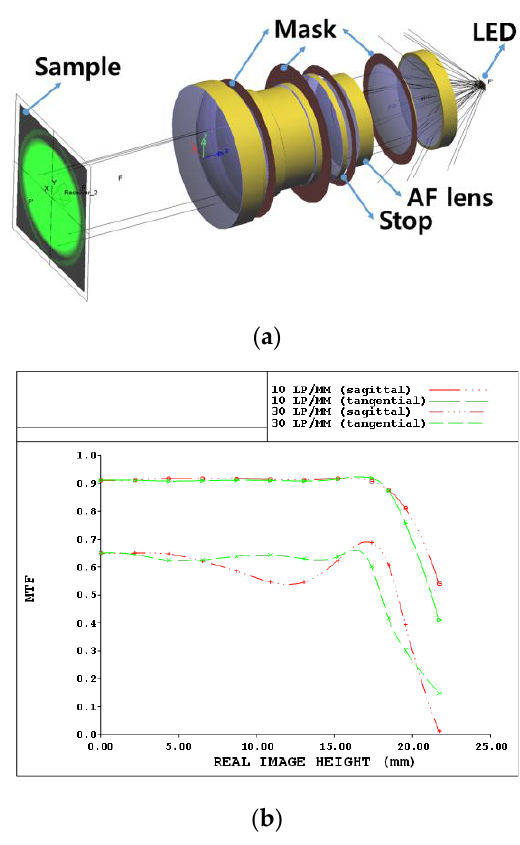
Figure 5. ( a ) The three-dimensional optical layout; and ( b ) the MTF graph of the designed double-Gauss lens.